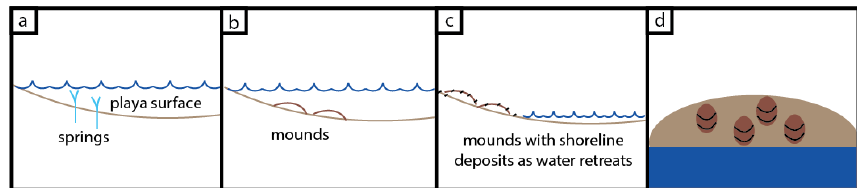
Figure 8. Conceptual model for how crescent features are formed in Deep Springs. (a) The waterline extends past the springs located at the margin of the lake. (b) Spring discharge carries mud and silt that gets deposited near the spring. (c) As the waterline retreats, subaerially exposing the spring deposits, evaporite precipitation marks strandlines on the mound topography. (d) Plan view of the mounds after the shoreline has retreated, leaving behind waterline marks on the